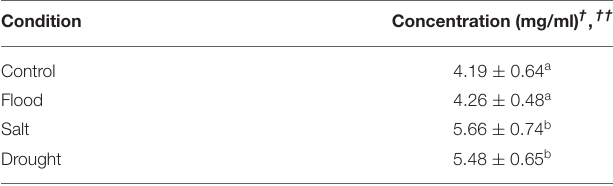
TABLE 4 | Soluble protein concentration of rice pollen